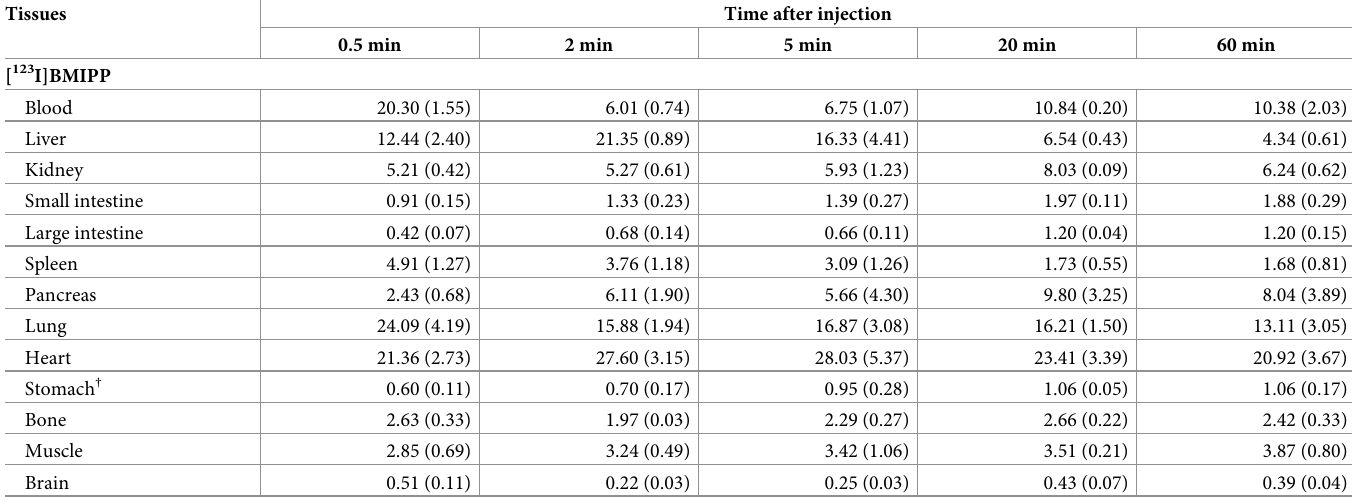
Data were presented as %injected dose/gram tissue. Each value represents mean (SD) for three mice. † presented as %ID/organ.